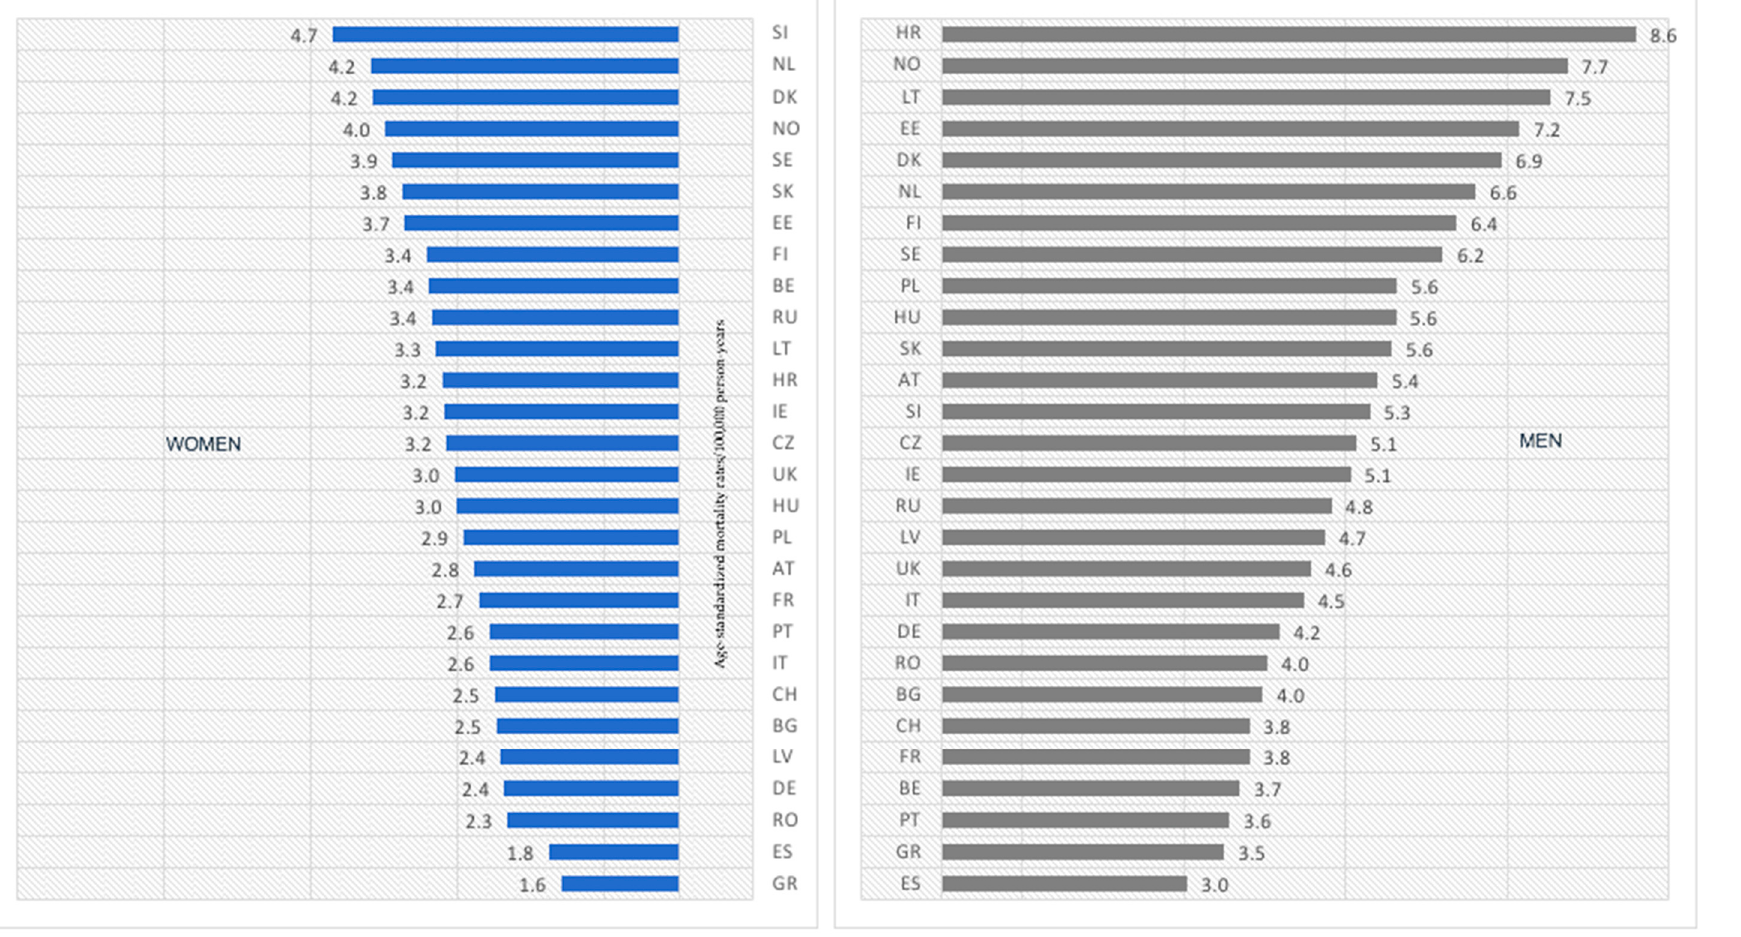
Figure 5. Age-standardized melanoma-mortality rates in women and men aged 45–74 years old in 2020 or the last available year (2018 or 2019) in 28 European countries ( SI—Slovenia; NL—the Netherlands; DK—Denmark; NO—Norway; SE—Sweden; SK—Slovakia; EE—Estonia; FI—Finland; BE—Belgium; RU—Russia; LT— Lithuania; HR—Croatia; IE—Ireland; CZ—Czech Republic; UK—United Kingdom; HU—Hungary; PL—Poland; AT—Austria; FR—France; PT—Portugal; IT—Italy; CH—